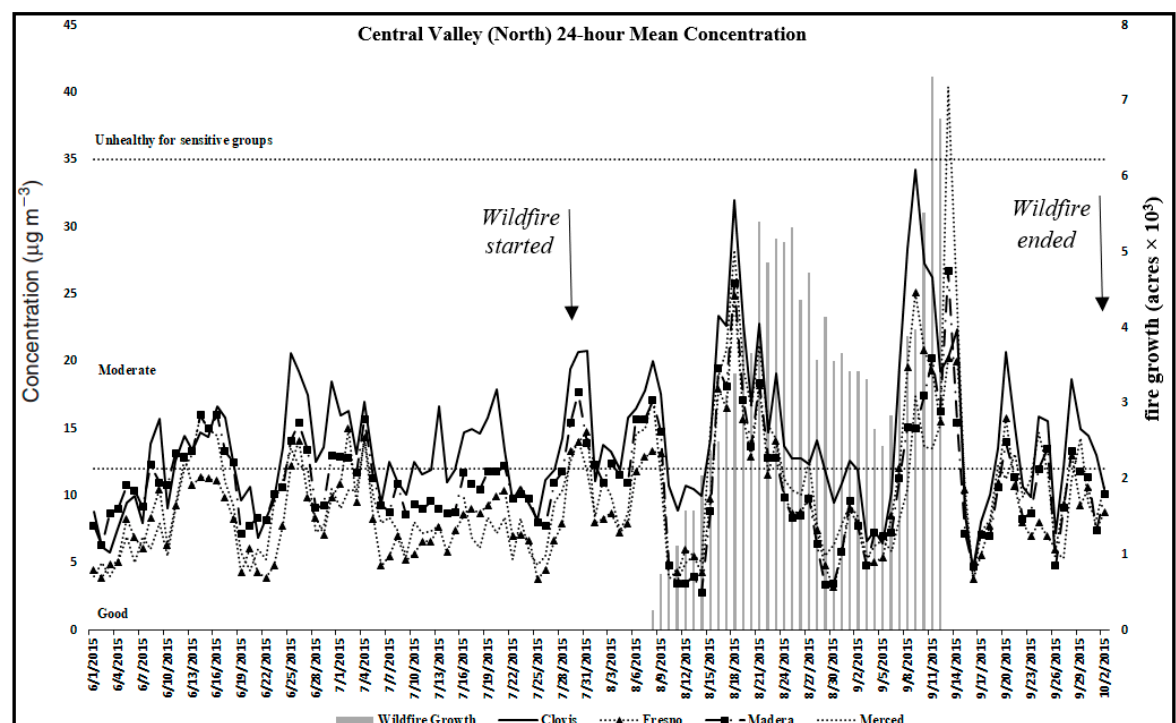
Figure 2. 24-Hour PM 2.5 concentrations with Air Quality Index (AQI) breakpoints for monitoring sites. Note: no daily fire growth data were available at the beginning of the fire.